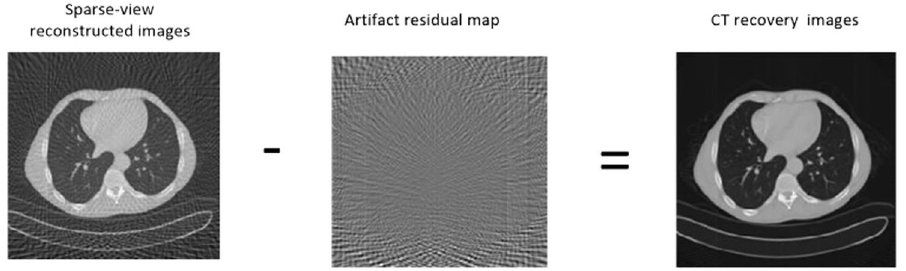
Figure 7. The process of removing artifacts from sparse reconstructed images in